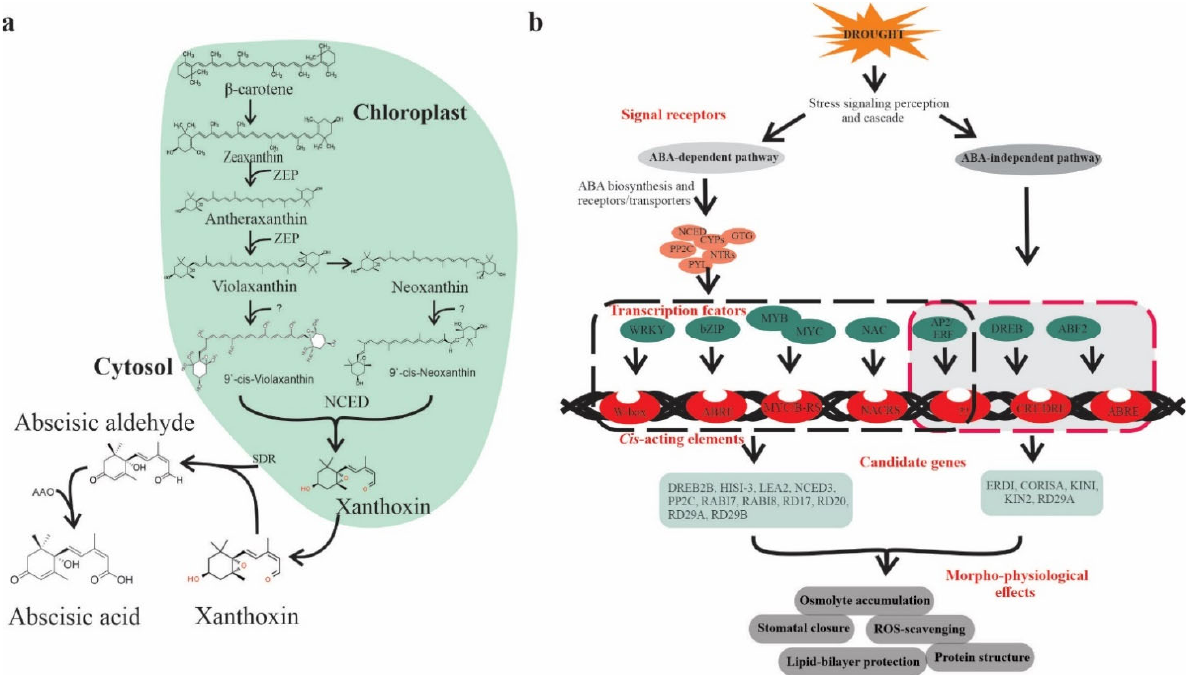
Figure 1. ABA biosynthesis and ABA-mediated drought-responsive pathways in plants. ( a ) Scheme of ABA biosynthesis. The precursors of ABA, β -carotene undergoes a series of oxidative reactions in the plastids and each step is catalyzed by specific enzyme such as ZEP (zeaxanthin epoxidase) or NCED (9- cis -epoxycarotenoid dioxygenase). The derived xanthoxin is exported to the cytosol and converted into ABA through an oxidation reaction mediated by AAO (aldehyde oxidase) and SDR (alcohol dehydrogenase/reductase), ( b ) ABA-dependent and -independent signaling pathways in the plant, which consists of several core components including ABA receptors and regulators. The ABA-dependent and -independent pathways are indicated by black and red arrows,